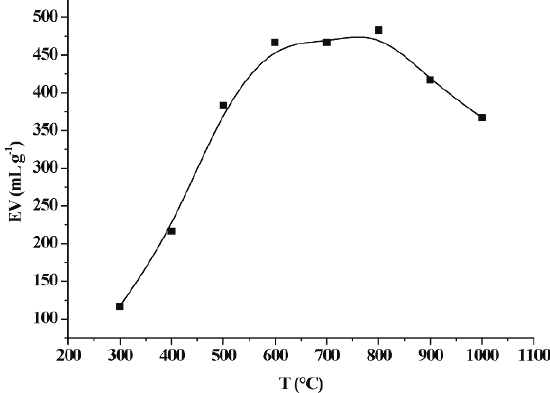
Figure 1. Expansion temperature curve of EG (EV is the volume of 1.0 g EG after expanding at different oven temperature).